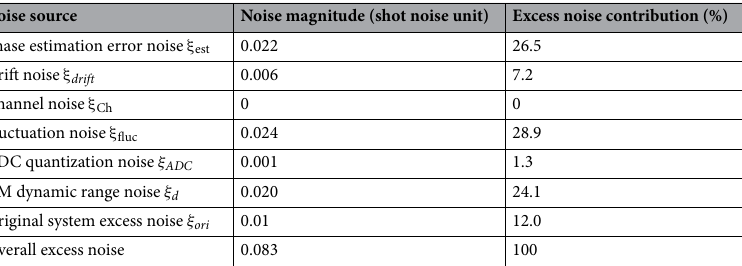
Table 2. Magnitudes and contributions of the different excess noise sources at 500 MHz repetition